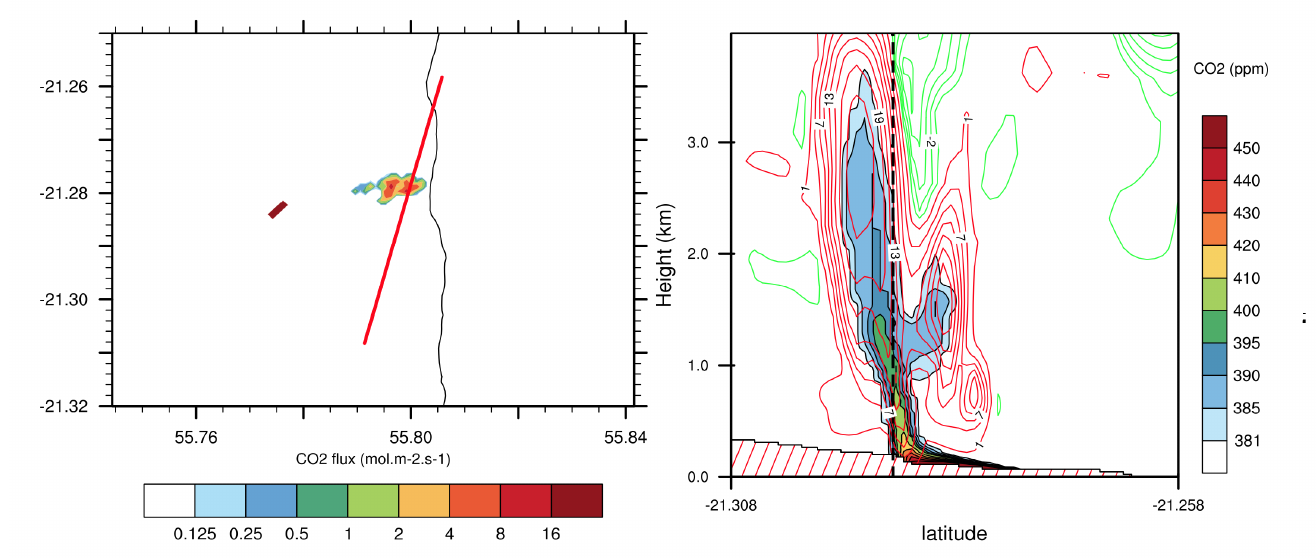
Figure 10. ( left ) CO 2 fluxes (in mol · m 2 · s − 1 ) on 6 April at 06 UTC. ( right ) Vertical section representing CO 2 concentration (ppm) and isolines of vertical wind intensity (ascending in red and subsiding in green). Dashed line corresponds to the cross section of Figure